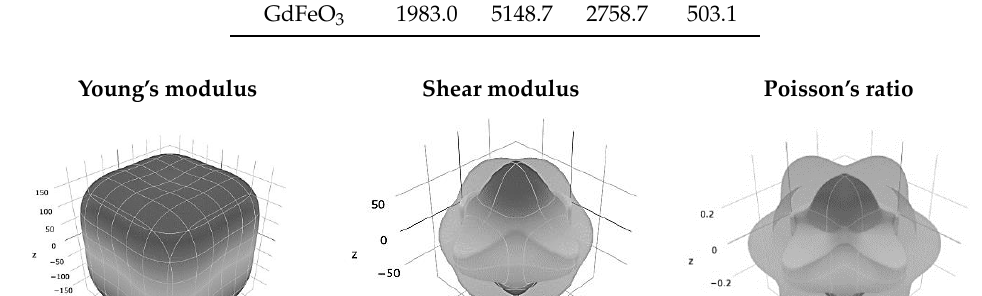
Figure 2. Total energy of LaFeO 3 , EuFeO 3 , and GdFeO 3 structures as a function of strain under the influence of three types of deformation tensor (E 0 is total energy of equilibrium structure).